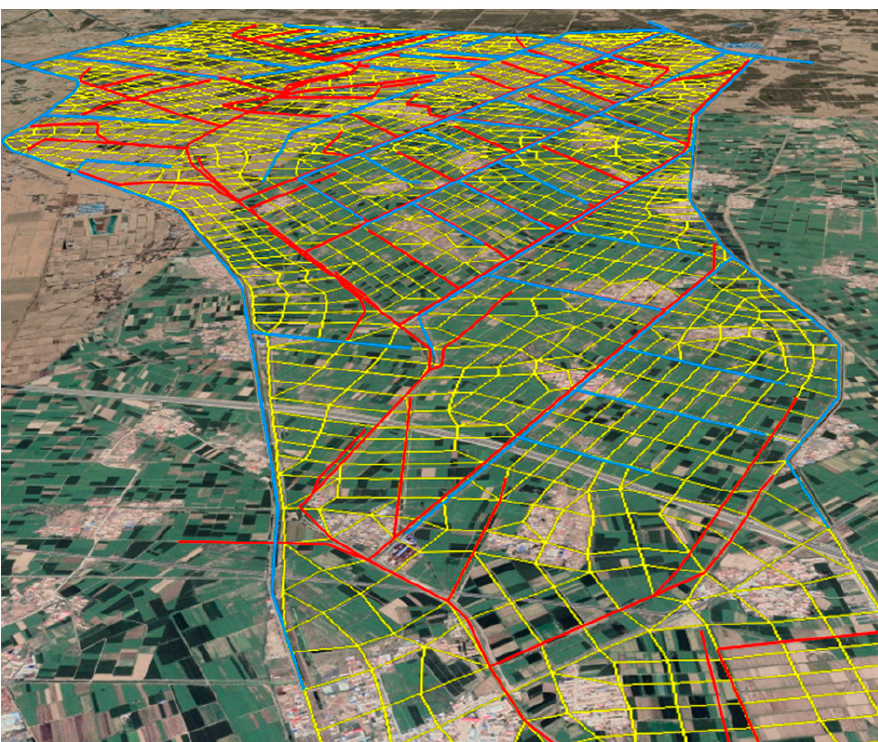
Figure 4. An example of spatial discretization. The red lines stand for canals, the blue lines stand for ditches, and the yellow grids stand for cells of the surface field, soil water, and groundwater.